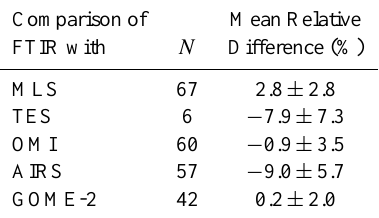
Table 2. Summary of the comparison between O 3 columns amount derived from FTIR and from various satellites data (MLS, TES, OMI, AIRS and GOME-2) over Addis Ababa. N represents number of